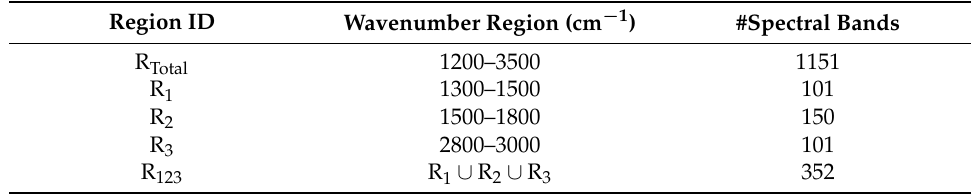
Figure 8. Relevant wavenumber regions selected for the SVM analysis. ( A ) R 1 : region from 1300 cm − 1 to 1500 cm − 1 ; ( B ) R 2 : region from 1500 cm − 1 to 1800 cm − 1 ; ( C ) R 3 : region from 2800 cm − 1 to 3000 cm − 1 . Table 4. Wavenumber regions of the IR spectroscopic samples of brain tissue to be analyzed by the SVM classifier using the RBF kernel.